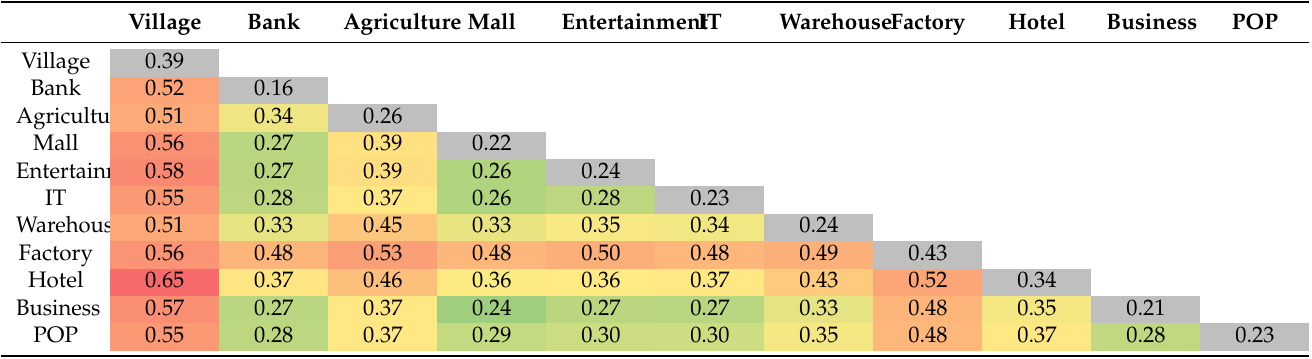
Table 5. Results of interactive detector model. (The colored grids represent the interactive associations of factor pair, and the grey grids are the individual associations between single factor and offender residences, which is equal to the results of the factor